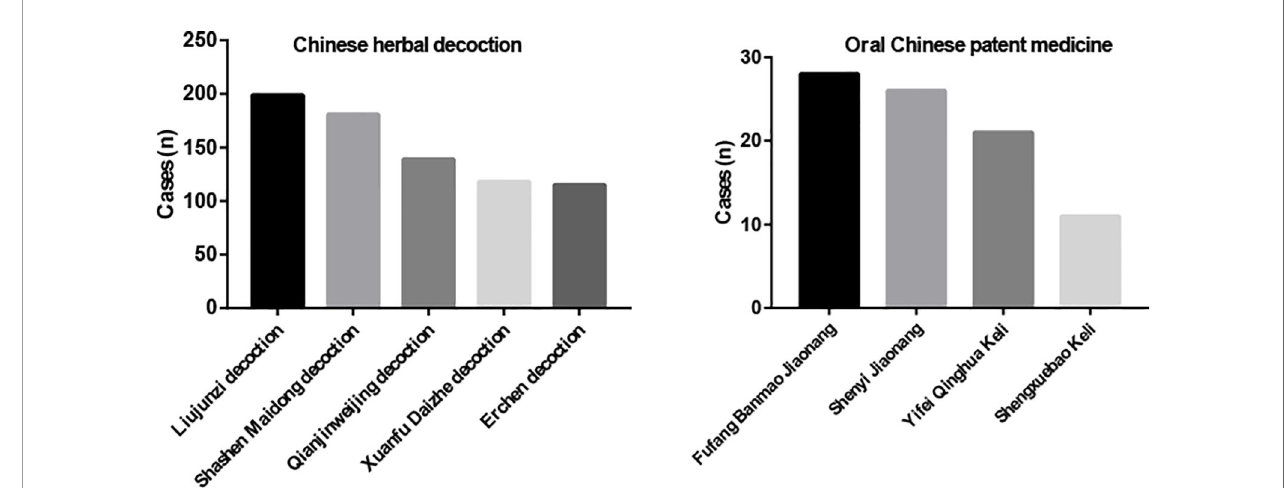
FIGURE 3 | Use of Chinese Herbal Medicine and Oral Chinese Patent